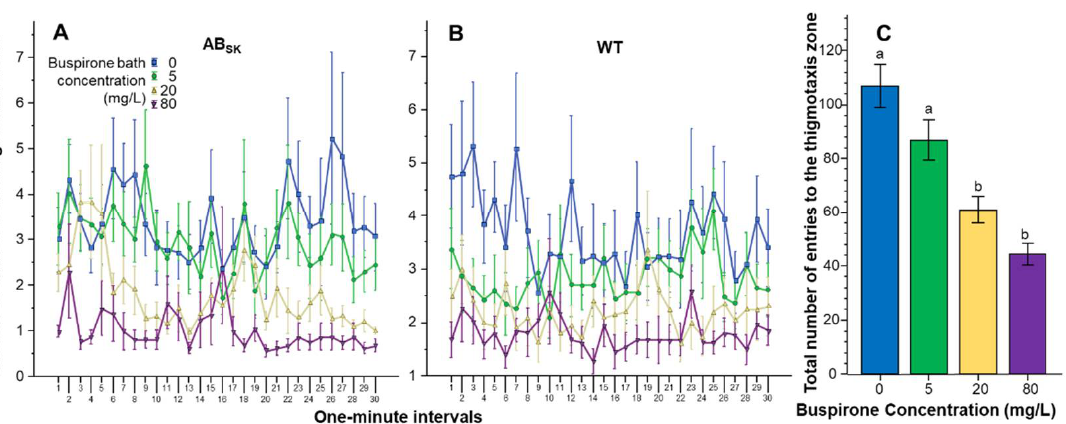
Figure 5. The number of entries to the thigmotaxis zone is dose dependently reduced by buspirone. Thigmotaxis zone entry frequency as a function of time (1-min intervals) is shown for ABSK ( A ) and WT ( B ) zebrafish. The legends show the buspirone concentrations employed (blue line with rectangle 0 mg/L, green line with circle 5 mg/L, yellow line with triangle 20 mg/L, and purple line with upside down triangle 80 mg/L). ( C ) shows the cumulative (total) number of entries to the thigmotaxis zone for the entire 30 min recording session, pooled for the two populations, exhibited by the zebrafish exposed to the different concentrations of buspirone (indicated underneath the X axis and also by the same color coding as in ( A , B ). Means + S.E.M. are shown. The results of Tukey HSD test are shown as letters above each bar of the bar graph ( C ). Bars that do not share one letter in common represent buspirone treatment groups that are significantly ( p < 0.05) different from each other. For detailed results of statistical analyses, see Results.